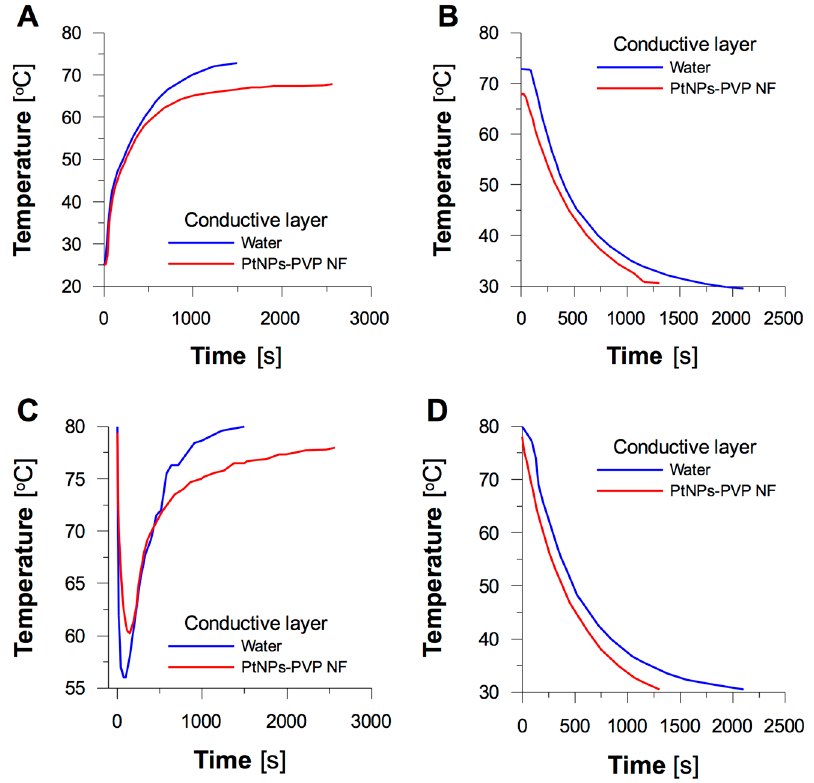
Figure 7. Time ‐ dependent changes of temperature obtained for ( A ) heating, and ( B ) cooling of the conductive layer; ( C ) heating, and ( D ) cooling of the circulating liquid.